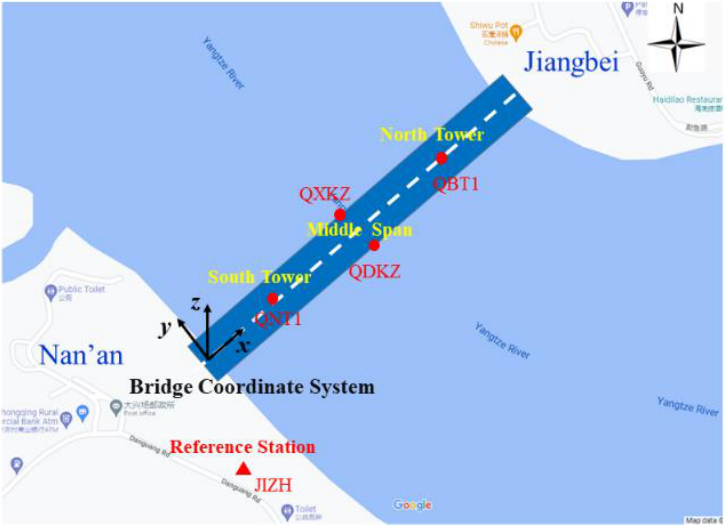
Figure 11. Low-cost GNSS stations are set up on the bridge. (The background figure is from Google Earth). The BCS is defined in this paper ( x and y denote the longitudinal and lateral direction of the bridge and z is orthogonal with the plane of x-o-y and denotes the height direction).